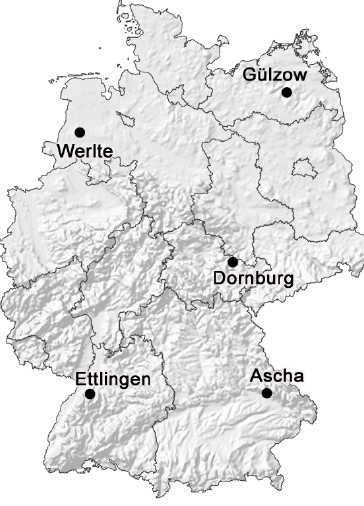
Figure 1. Locations of the five study sites in Germany. Detailed information and descriptions of the site characteristics can be found in Table